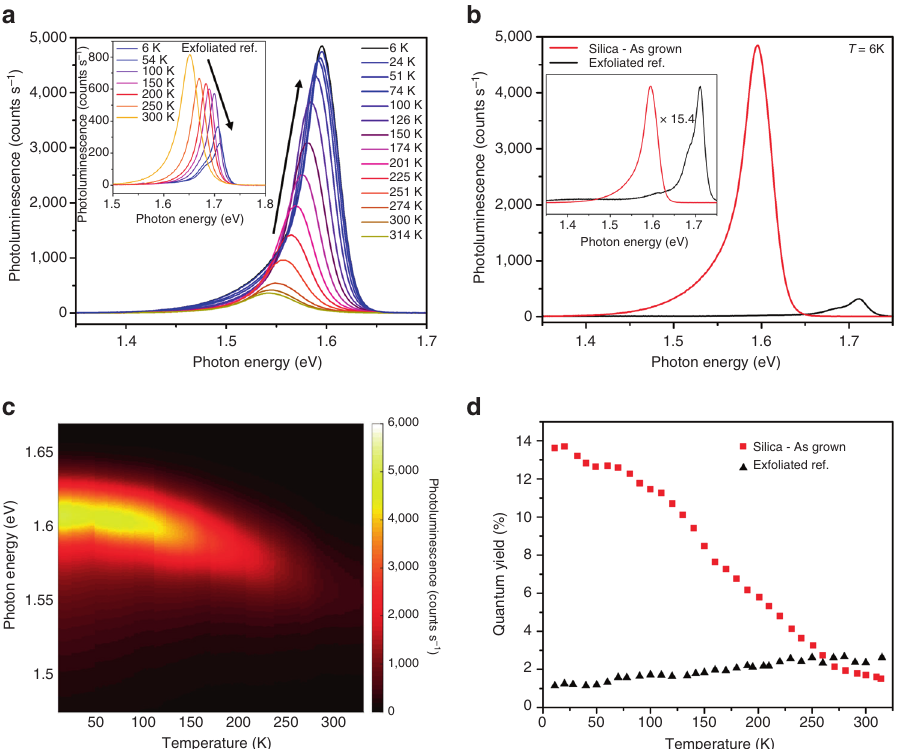
Fig. 5 Low-temperature photoluminescence of strain-engineered monolayer WSe 2 . a Temperature dependent photoluminescence spectra of as-grown monolayer WSe 2 (tensile strained), inset shows the same measurement on an exfoliated monolayer WSe 2 sample. b Photoluminescence spectra of as- grown (tensile strained) WSe 2 and exfoliated WSe 2 measured at 6 K, inset shows normalized spectra. c Two dimensional plots of photoluminescence spectra and intensity of as-grown (tensile strained) monolayer WSe 2 . d Temperature dependence of the PL QY for as-grown (tensile strained), and exfoliated WSe 2 as a function of